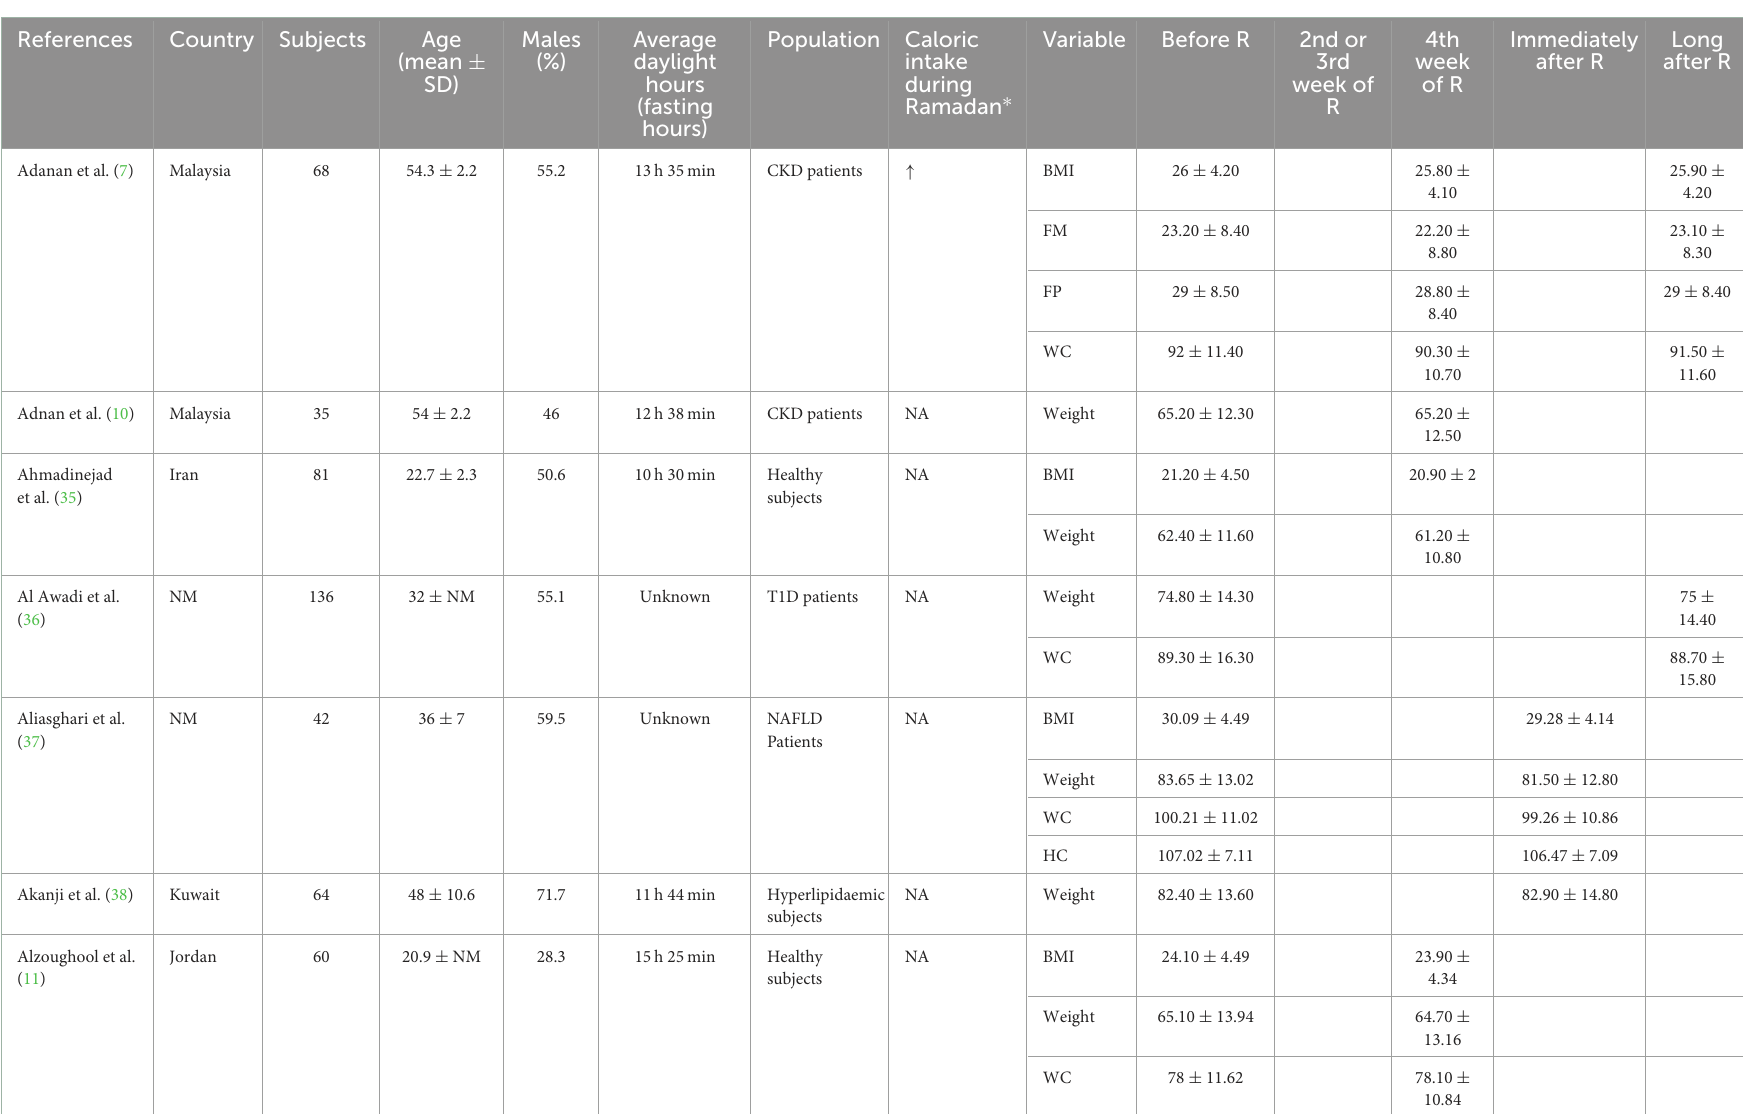
TABLE 1 Characteristics of studies included in the